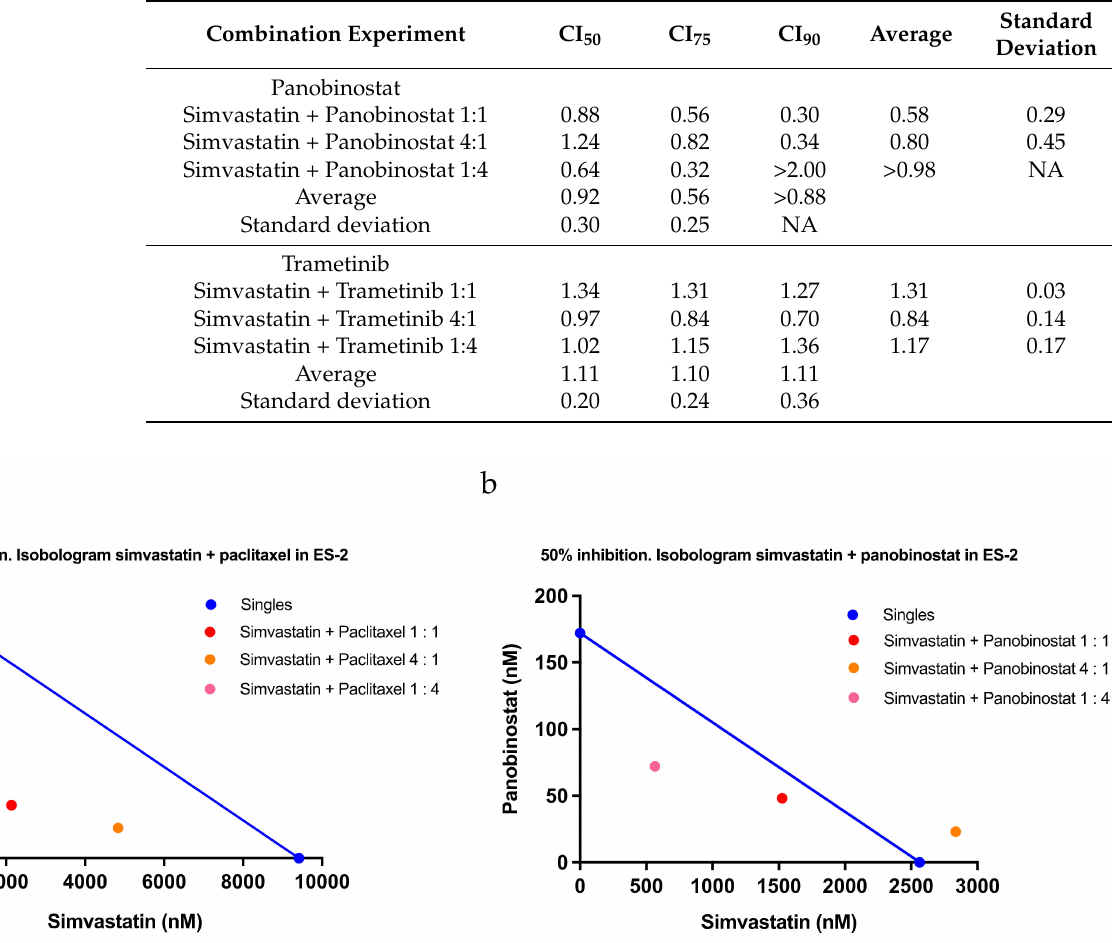
Figure 5. Synergistic effects of simvastatin and paclitaxel and panobinostat in ES-2 cells. An isobolo- gram is a dose-oriented plot which reveals whether drug combinations are synergistic. On the axis, the calculated doses of the single compounds were plotted as the blue points that give the pre-set growth effect. Both points were connected with a straight blue line as an additivity line. For the drug combinations, it was calculated which dilutions gave the pre-set growth effect and the concentrations of the individual components at this point were plotted in the isobologram. The combinations of sim- vastatin and each drug by condition in the legend were plotted with the red, orange, and pink points. In case of an additive drug effect, the drug combination will lie close to the additivity line. In case of synergy or antagonism, the points will lie under or above the line, respectively. ( a ) Isobologram for 90% growth inhibition by simvastatin and paclitaxel. ( b ) Isobologram for 50% growth inhibition by simvastatin and